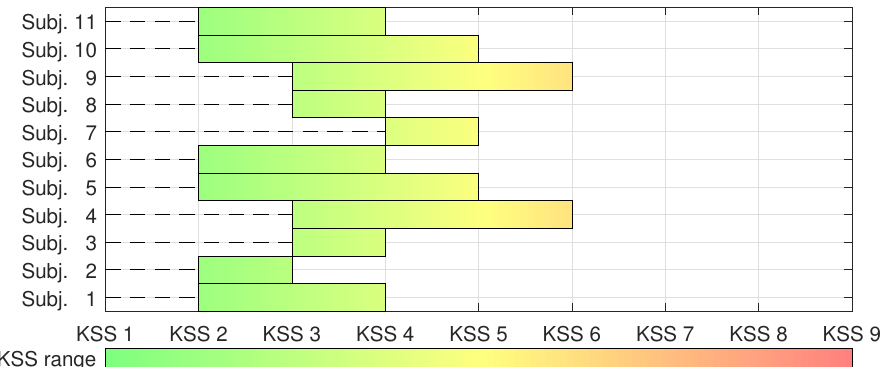
Figure 8. Reported KSS range of each test subject. For each subject, the lower limit shows the reported KSS level at the beginning of the experiment and the upper limit shows the reported KSS level at the end of the